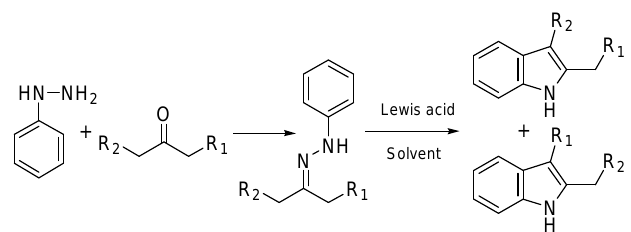
Figure 9 . Formation of indoles from dissymmetric ketones by the Fisher indole synthesis. In the work of Carlson and Gautun, PLS analysis is used to identify critical properties of the reaction system so that both conditions that are favorable for the reaction as well as conditions that can fail can be